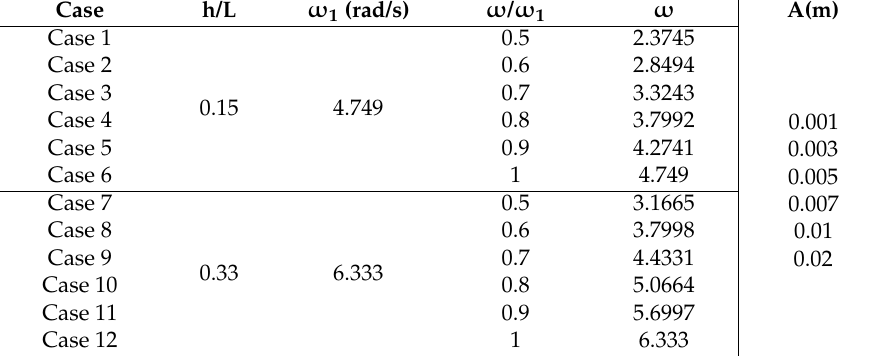
Table 2. The numerical case